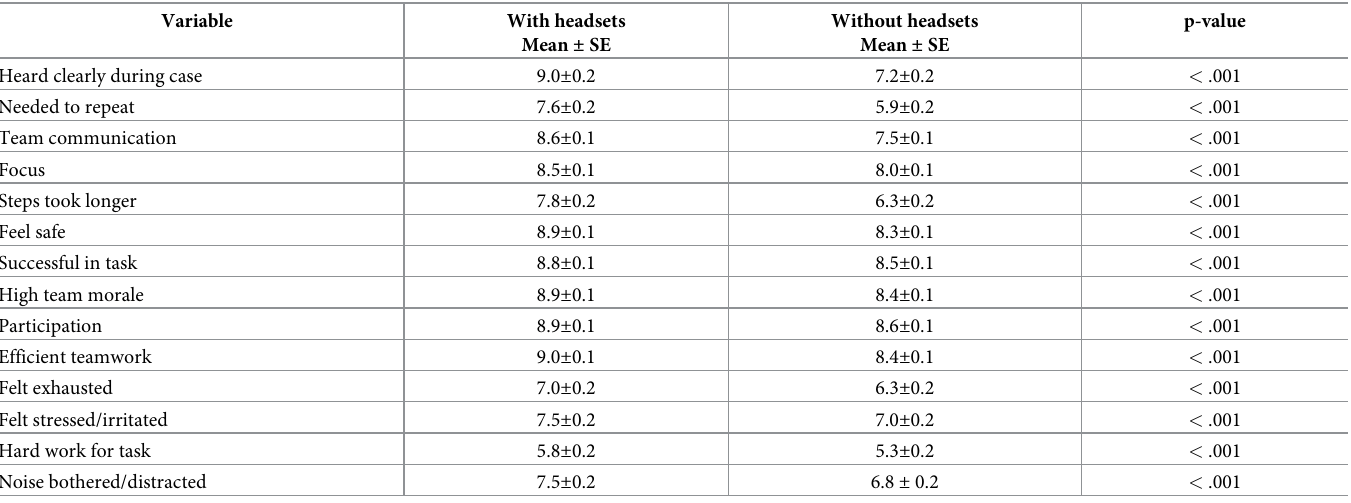
Table 3. Mean scores for individual items of the survey a .